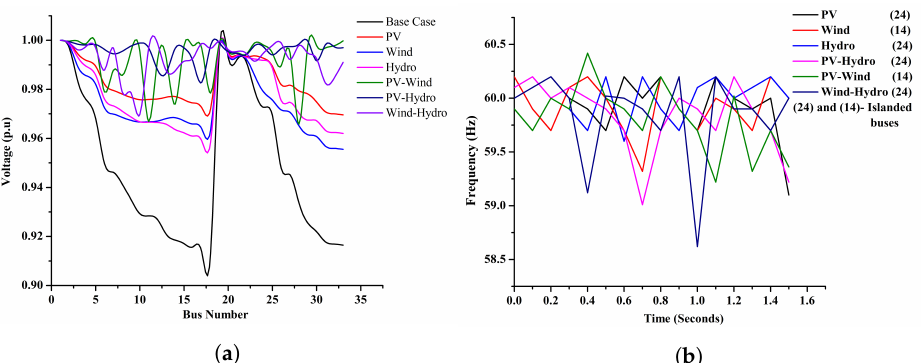
Figure 3. Voltage and frequency values. ( a ) Values (Voltage)- 33 bus system. ( b ) Values (Frequency)- 33 bus system.